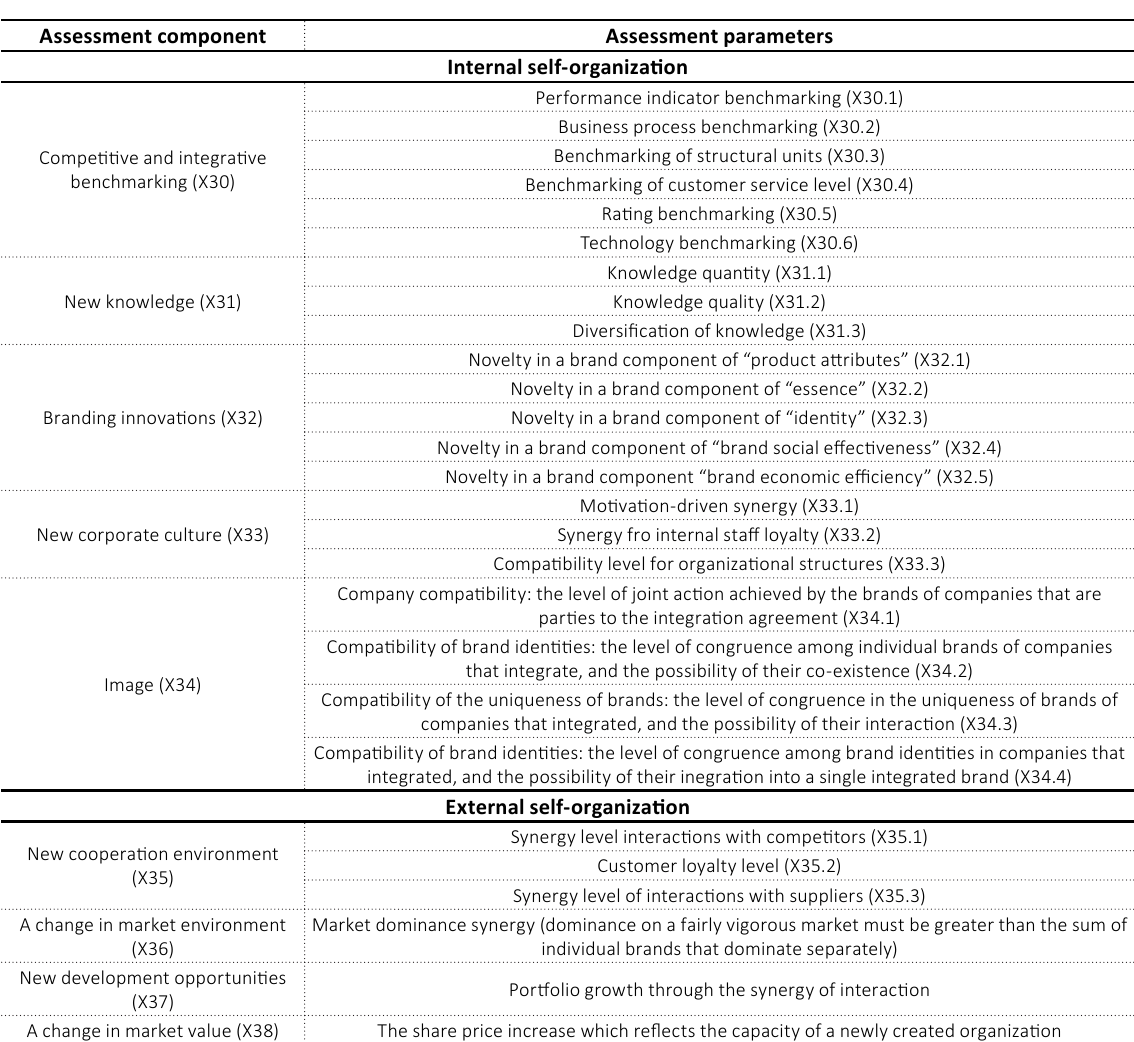
Table B1. A framework for parameters estimation for the components of synergetic effect from brand integration within an integrated business